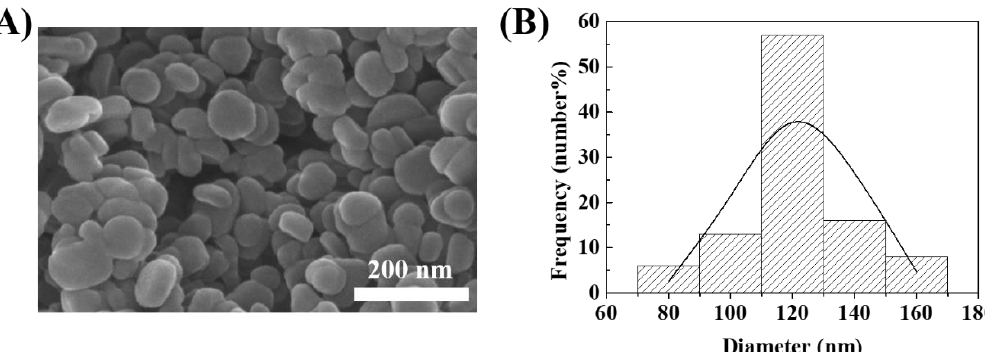
Figure 2. ( A ) Scanning electron microscopic (SEM) image and ( B ) corresponding particle size distribution for MTX-LDH. The SEM images were directly obtained from the powdered sample without dispersion in solvent. The acceleration voltage was set as 30 kV. The histogram of size distribution (bar with diagonal bars) was obtained from the randomly selected 100 particles in the SEM images, and the normal distribution (solid line) was fitted with normal distribution function in Microsoft Excel ® .